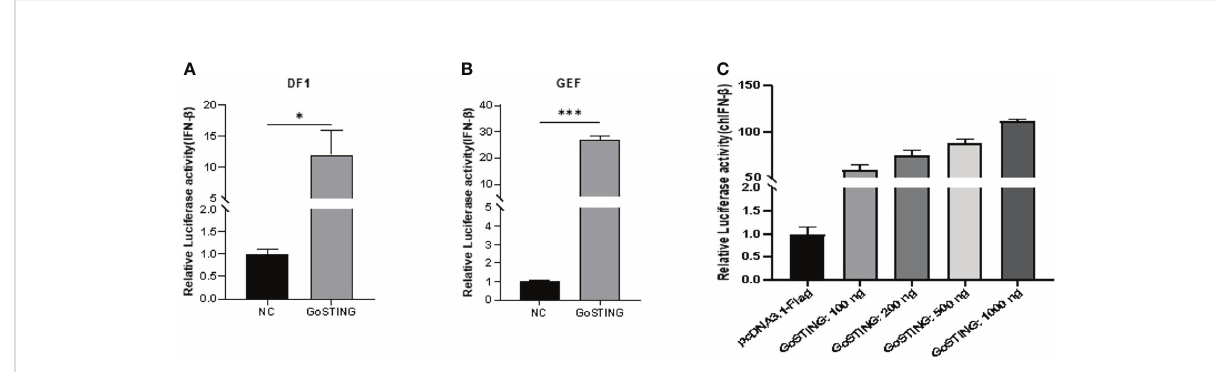
FIGURE 4 GoSTING is involved in regulating IFN- b . (A) DF-1 cells were cotransfected with luciferase reporter plasmids (pRL-TK and pGL-IFN- b -Luc) and pcDNA3.1-GoSTING-Flag or empty plasmid. Luciferase assays were performed after 24 hours of cotransfection. (B) GEFs were cotransfected with IFN- b luciferase reporter plasmids and with pcDNA3.1-GoSTING-Flag or pcDNA3.1-Flag. Luciferase assays were performed 24 hours after transfection. (C) GoSTING dose-independently induced IFN- b induction. The difference between the experimental and control groups was *p < 0.05 or ***p < 0.001.